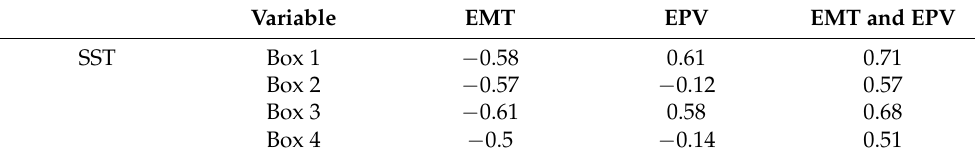
Table 2. Correlation between monthly averages of sea surface temperature (SST), Ekman Mass Transport (EMT), and Ekman Pumping Velocity (EPV) in all boxes from 2007 to